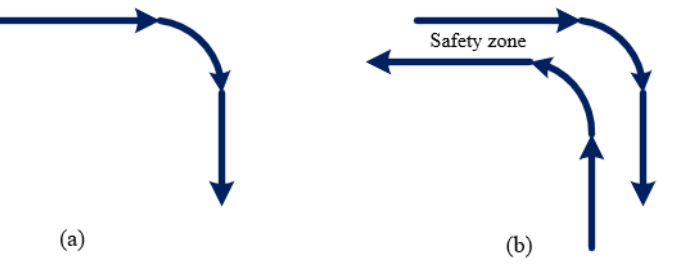
ISPRS Int. J. Geo-Inf. 2021 , 10 , x FOR PEER REVIEW Figure 10. Turning: ( a ) in one way at the same altitude, ( b ) in two ways at the same height.